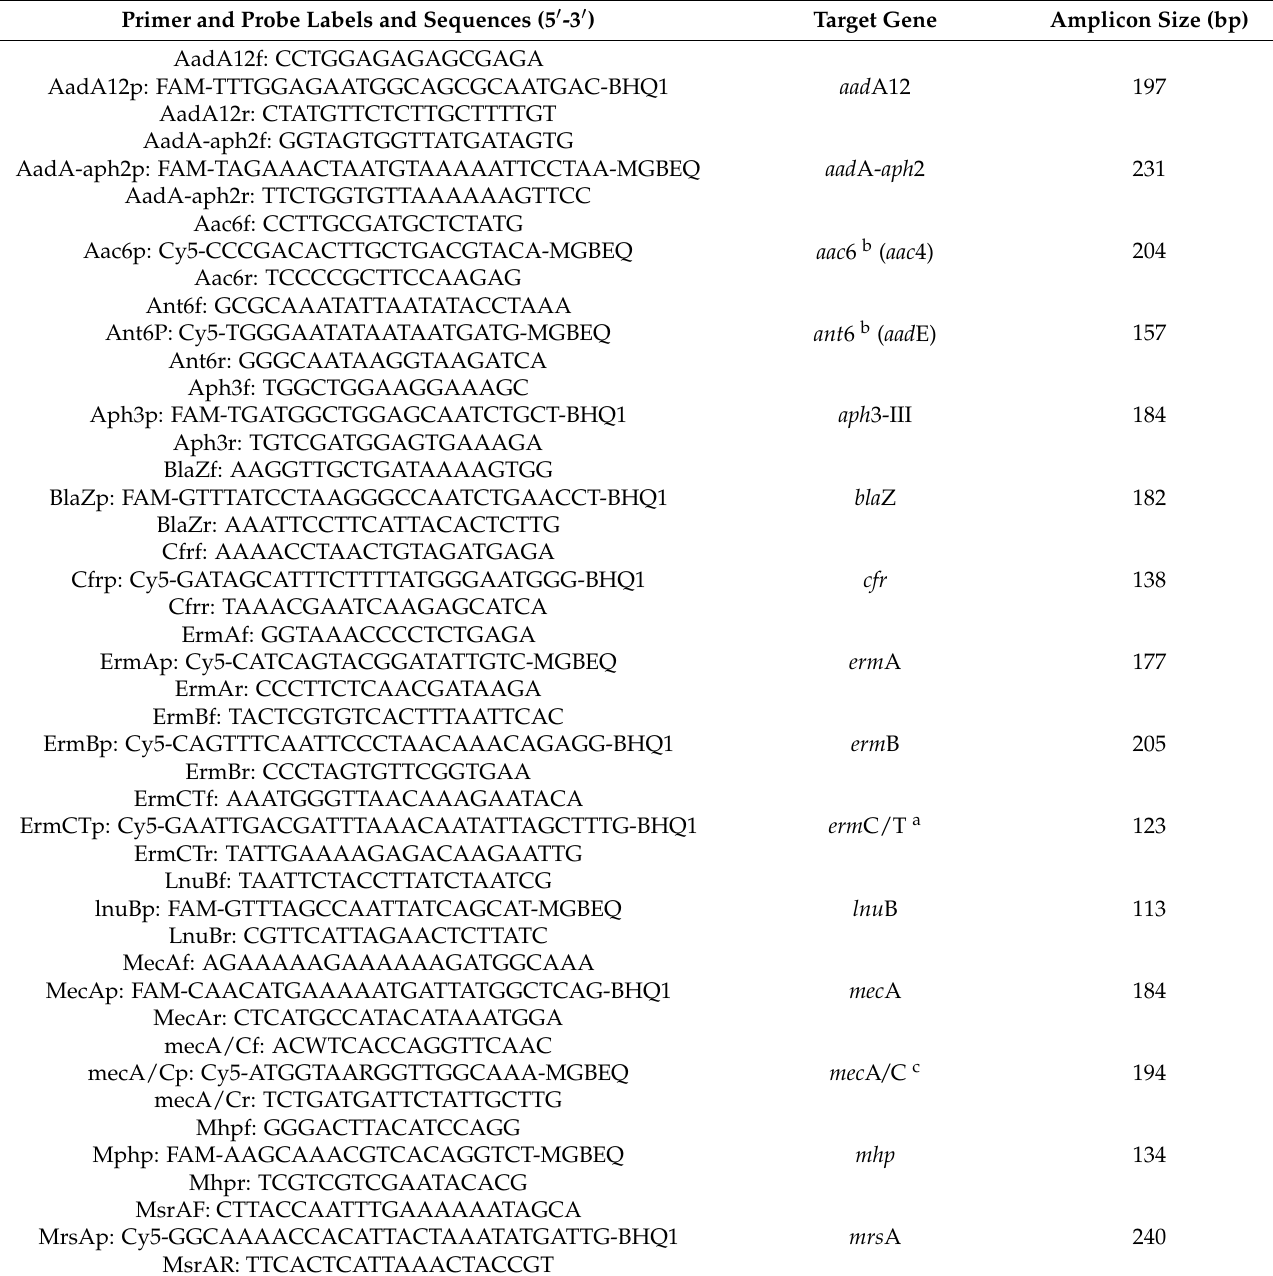
Table 1. Primers and probes designed in this study for the detection of AR genes, respective targets and dimensions of the amplification